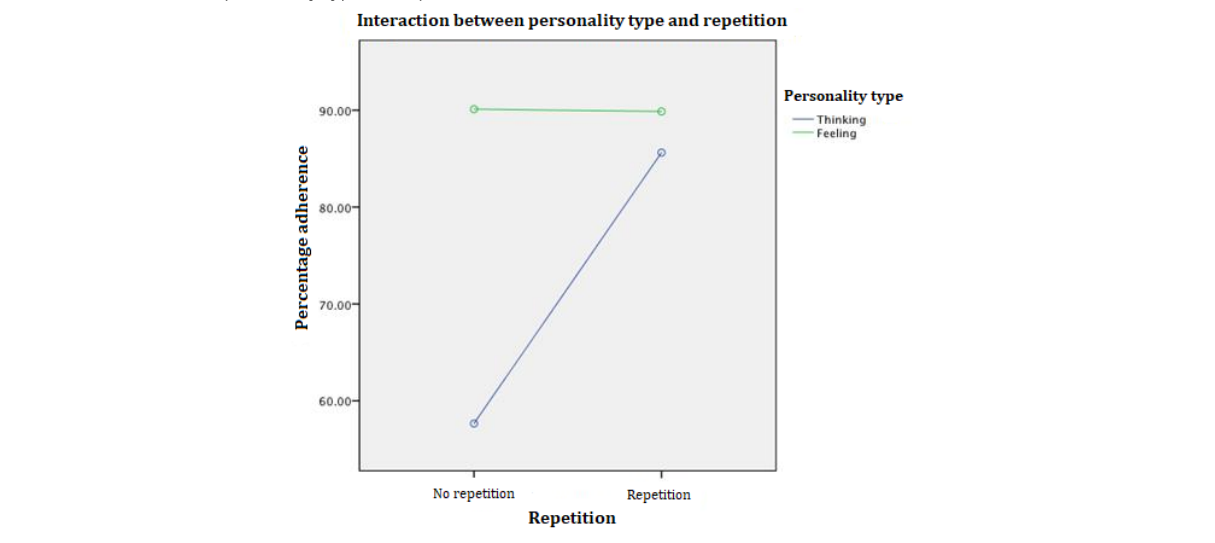
Figure 4. Interaction effect of personality type and